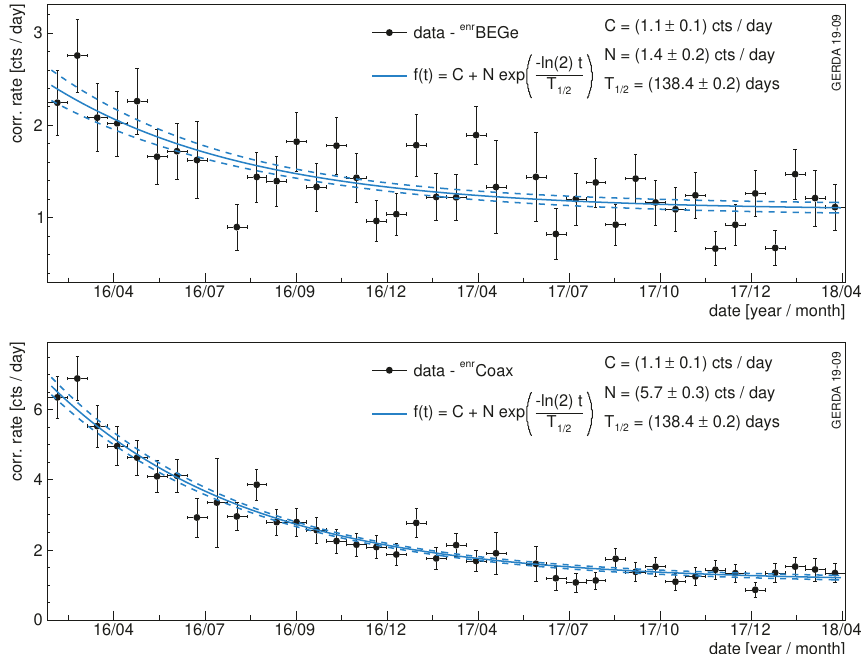
Figure 10. (cid:11) events time distribution in [3500 ; 5250] keV with a binning of 20 days for 27 enr BEGe (top) and 7 enr Coax (bottom)